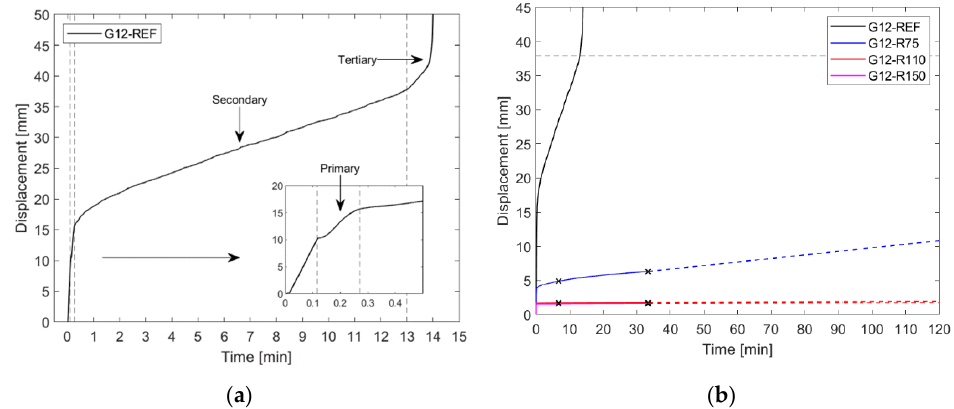
Figure 10. Results of creep experiments: ( a ) exemplary time–displacement history for the reference sample G12 (dashed lines represent delimitation among phases of creep behaviour); ( b ) extrapolated displacement history for test series G12 (dashes, color lines represent extrapolated values based on two points marked with “ x ” symbol).